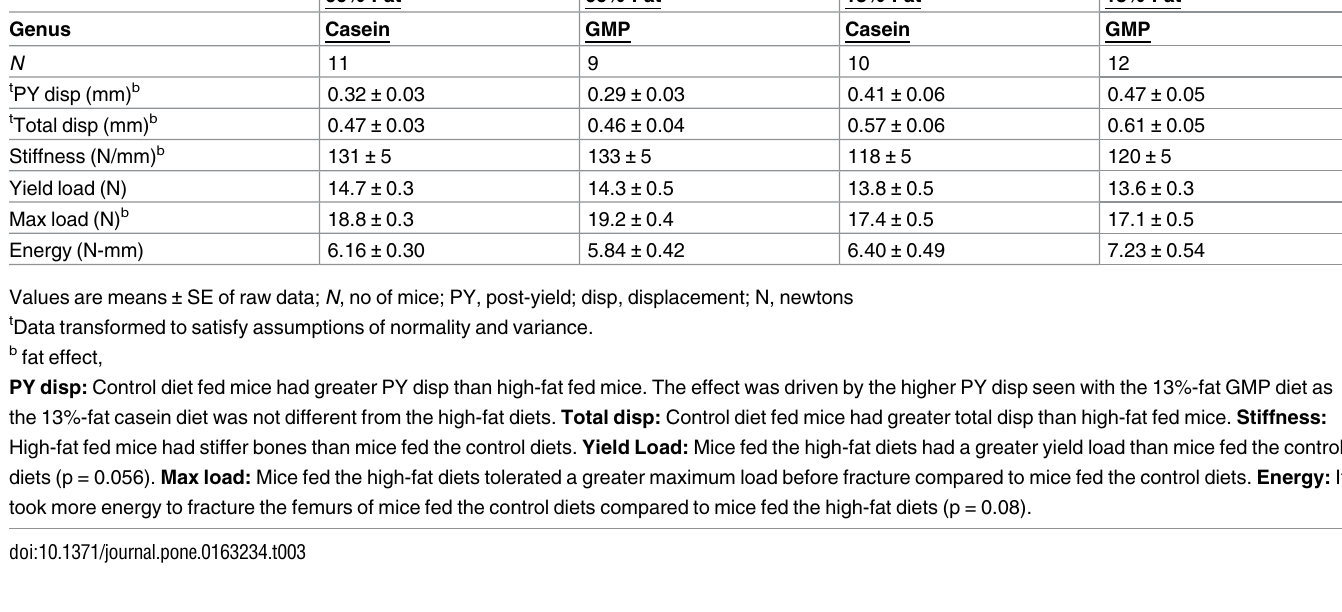
on the raw data. PCA linearly transforms the raw data into an equal number of mutually orthogonal PC’s, which is a linear function of the raw data [39, 40]. Further analysis is contin- ued on only those PC’s with an Eigenvalue greater than one. The analysis included 16 whole bone femoral measurements and this yielded four PC’s with an Eigenvalue > 1, which, all together, accounted for 79% of the variance as shown in Table 6. The PC’s are comprised of all measures, but interpretations can be made based on the coefficientsof the Eigenvectors, Table 7. PC1 is “size-like” as the major contributors are cross-sectional area, perimeter, outer minor axis, outer major axis, and CSMI. PC2 is “ductility-like” as post-yield deflection,total deflection,and energy to failure are the most prominent contributors. PC3 appears to be “shape-like” as the major contributor is shape factor. PC4 is the most difficult to interpret as